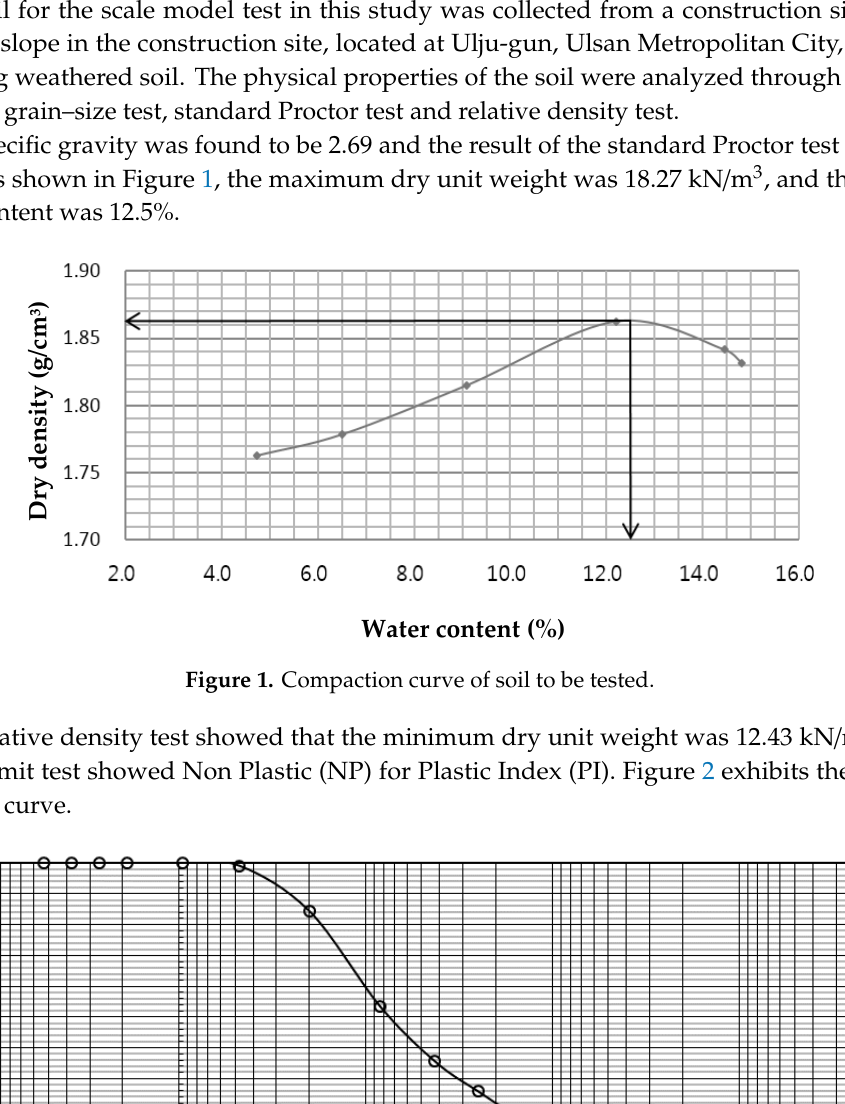
Figure 2. Grain – size distribution curve of soil to be tested.